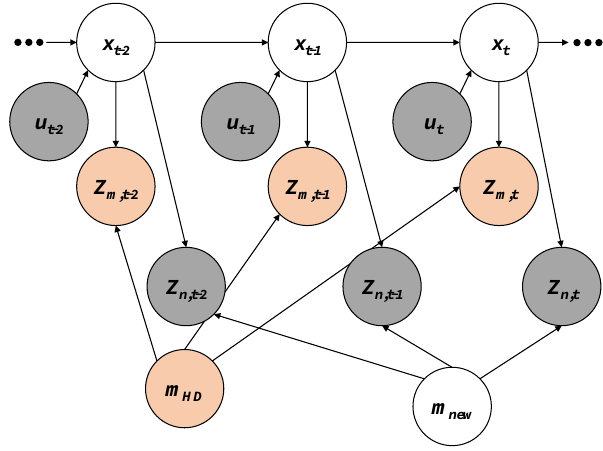
Figure 3. Graph representation for HD map-based new feature layer